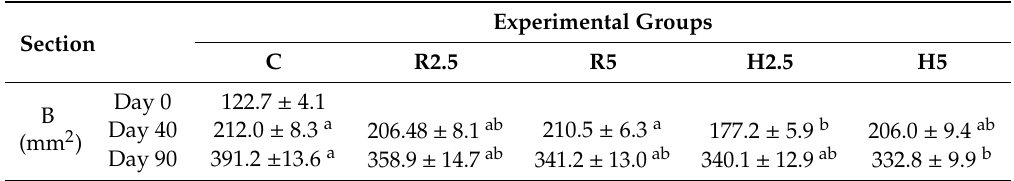
B: transverse area of the white muscle. Di ff erent lower-case letters superscripts in each row indicate significant di ff erences ( p < 0.05) among the experimental groups, within each sampling time. Values are expressed as mean ±